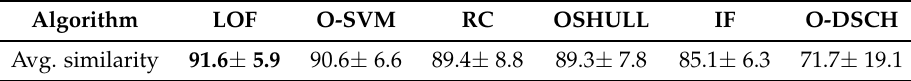
Table 1. Average similarity (%) ± standard deviations for the different